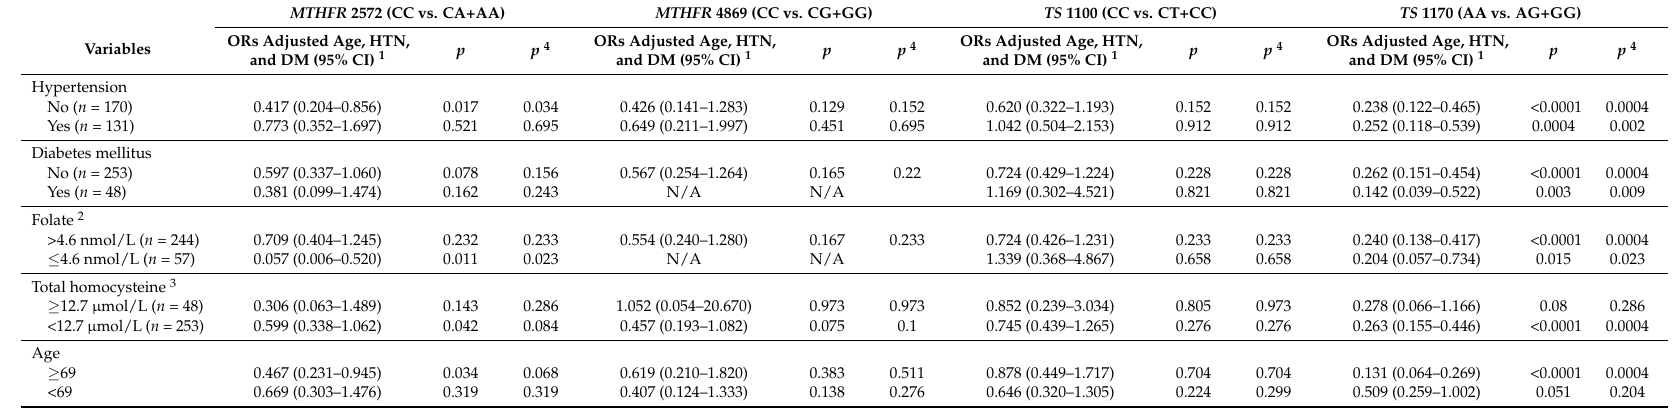
Table 3. Stratified effects of MTHFR and TS gene polymorphisms on osteoporosis prevalence.